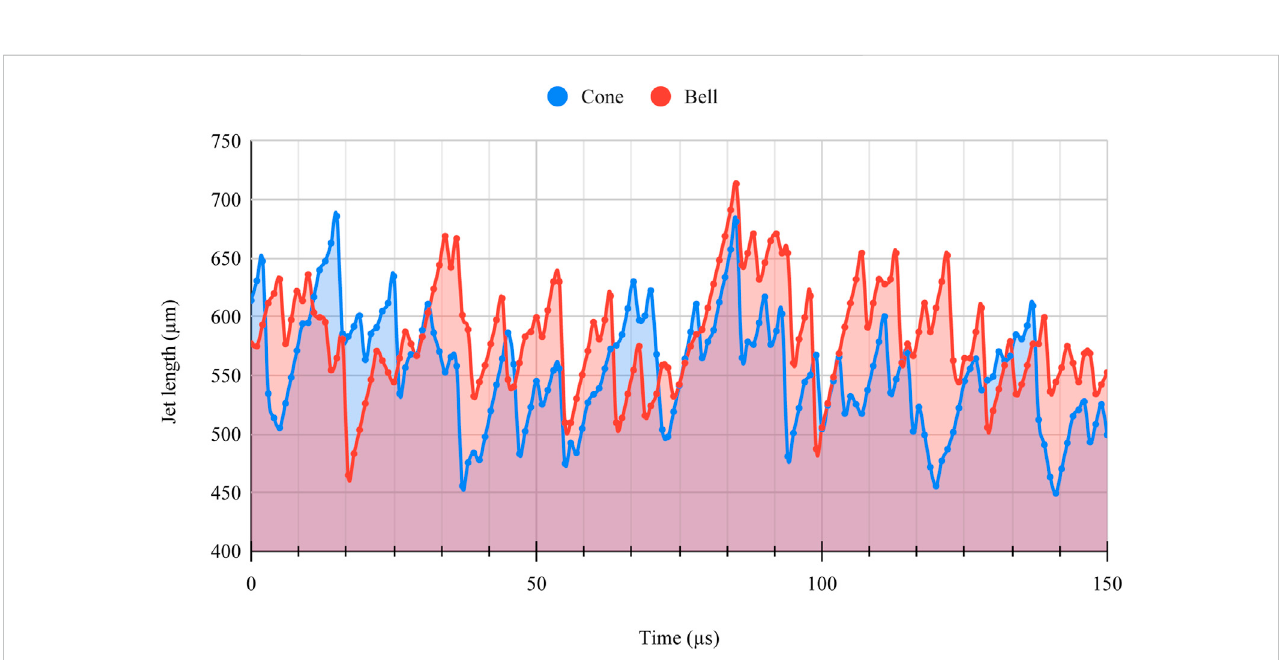
FIGURE 13 Transient evolution of the jet length for cone- and bell-shaped geometry ascertained from two-phase fl ow